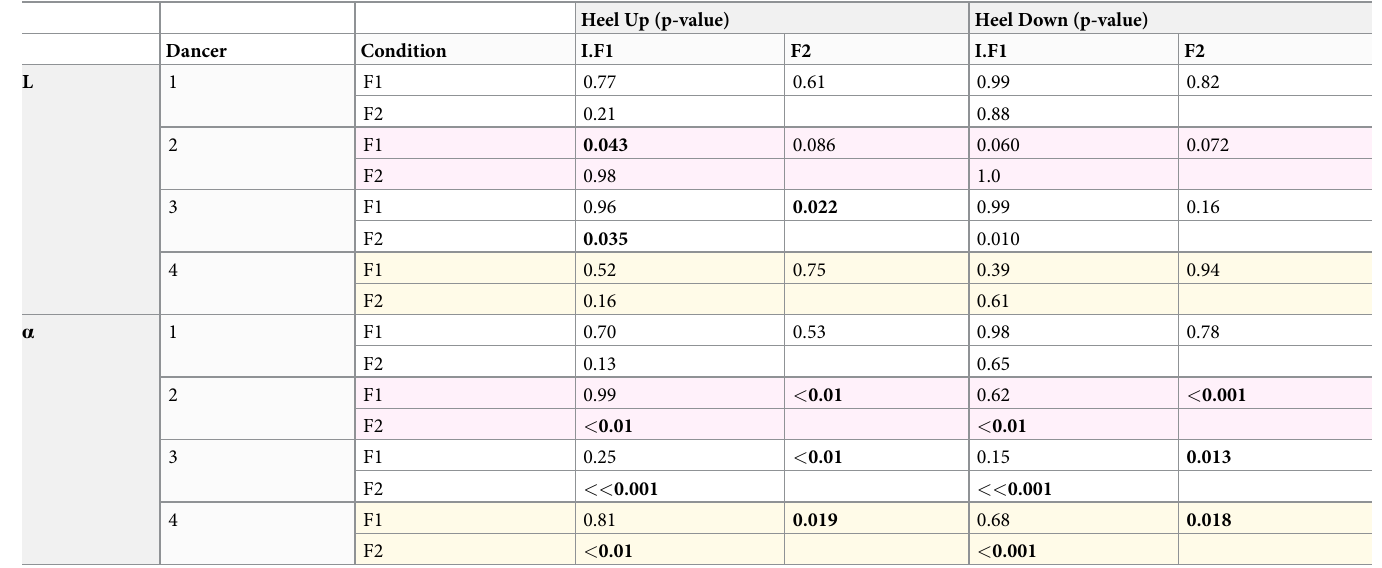
Table 2. Results of a non-parametric multiple comparisons test.